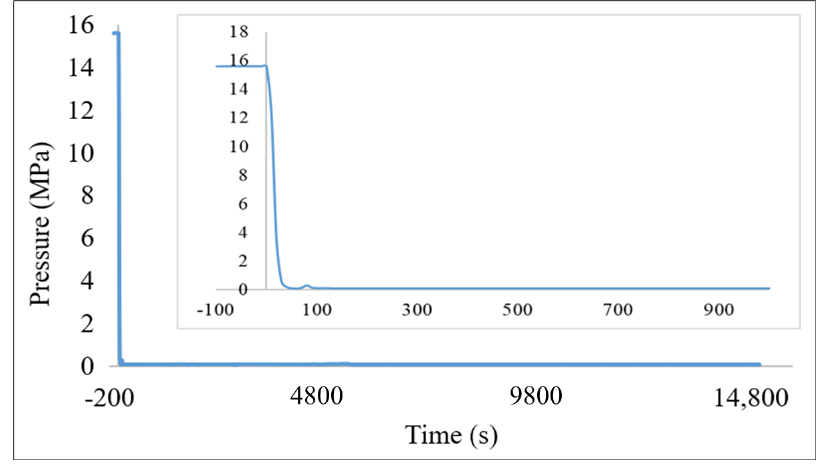
Figure 7. Pressure in the pressurizer.